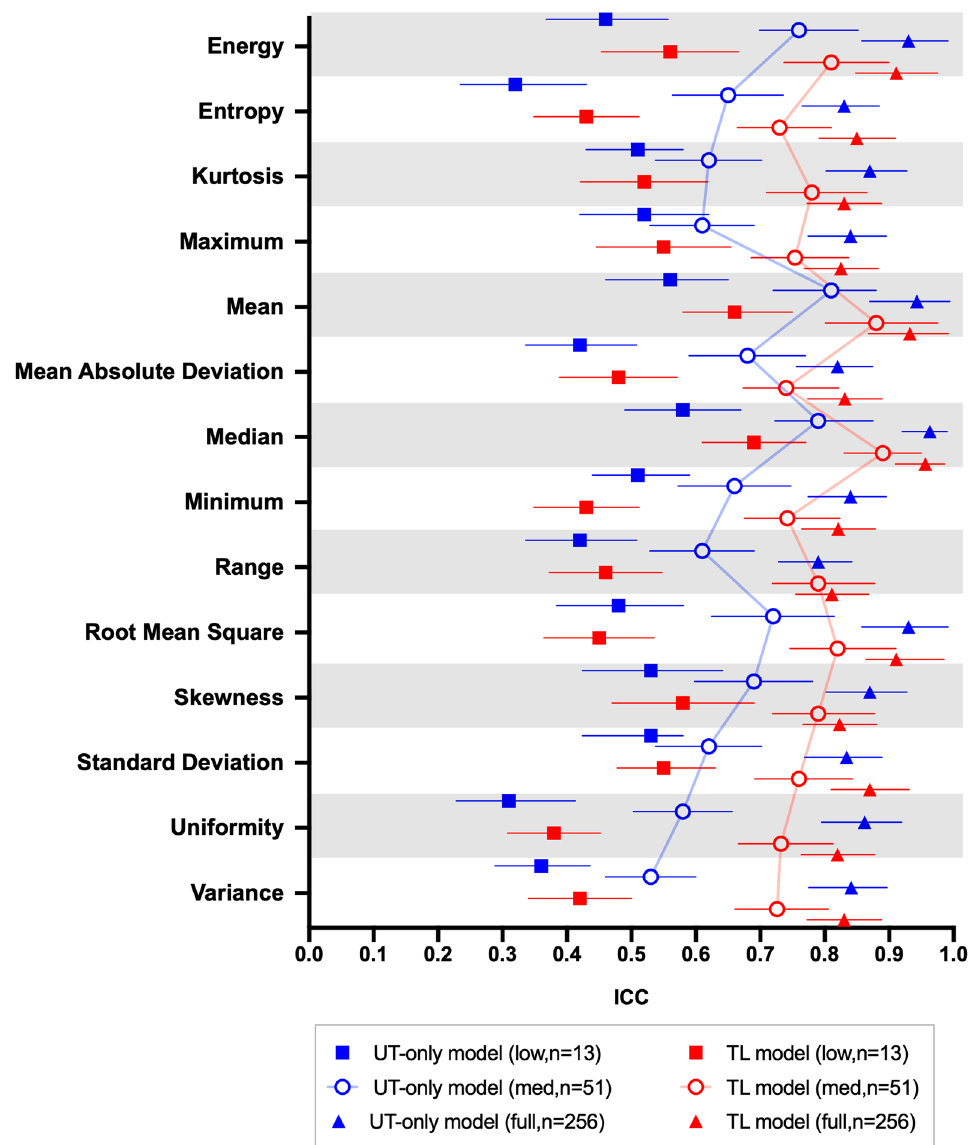
Fig. 6 Intraclass correlation coefficient (ICC) values for ADC radiomics features (first‑order) obtained by manual and automatic segmentation of uterine (UT)‑only and TL models with various sample sizes. Data are presented as median with error bars indicating 95% confidence